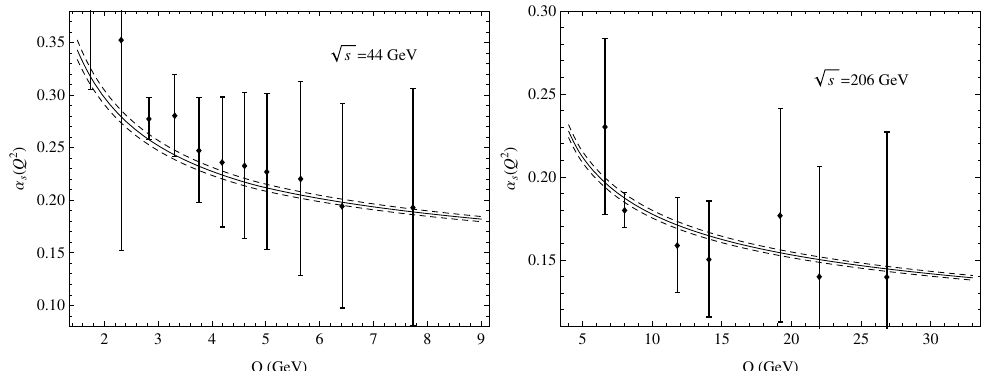
Figure 18. The extracted running coupling α s ( Q 2 ) from the thrust ( 1 − T ) distributions by comparing the PMC predictions with the experimental data measured at 206 GeV [1]. As a comparison, the solid line is the world average evaluated from α and two dashed lines represent its